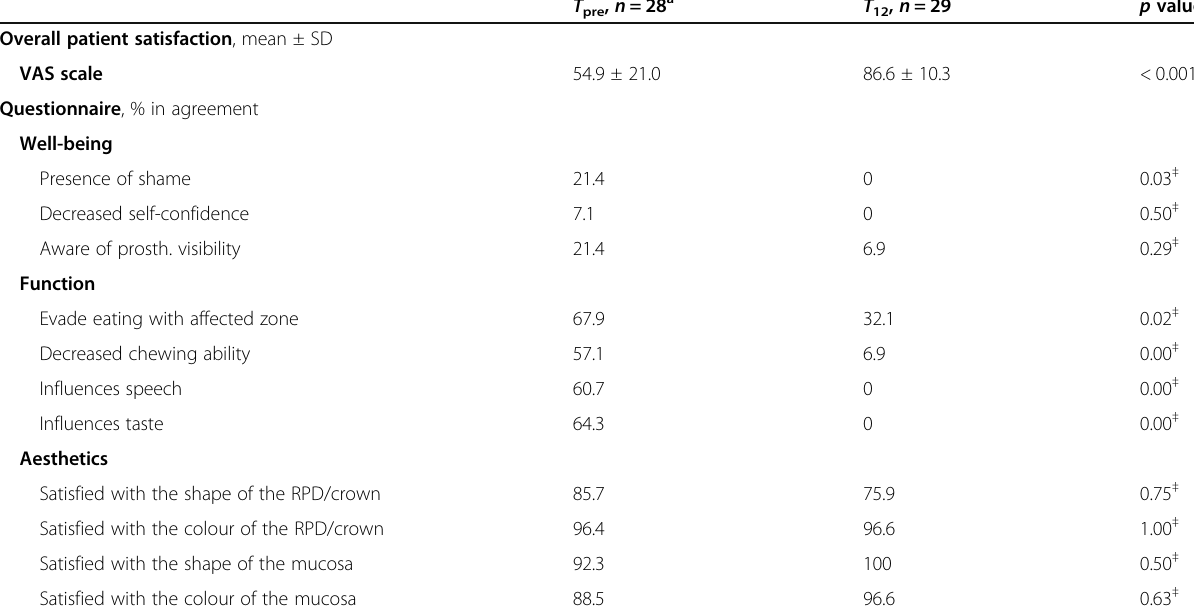
Table 5 Patient satisfaction was rated on a 0 – 100 VAS scale and further clarified through a questionnaire. T pre is the time prior to implant placement. T 12 is 12 months after definitive crown placement